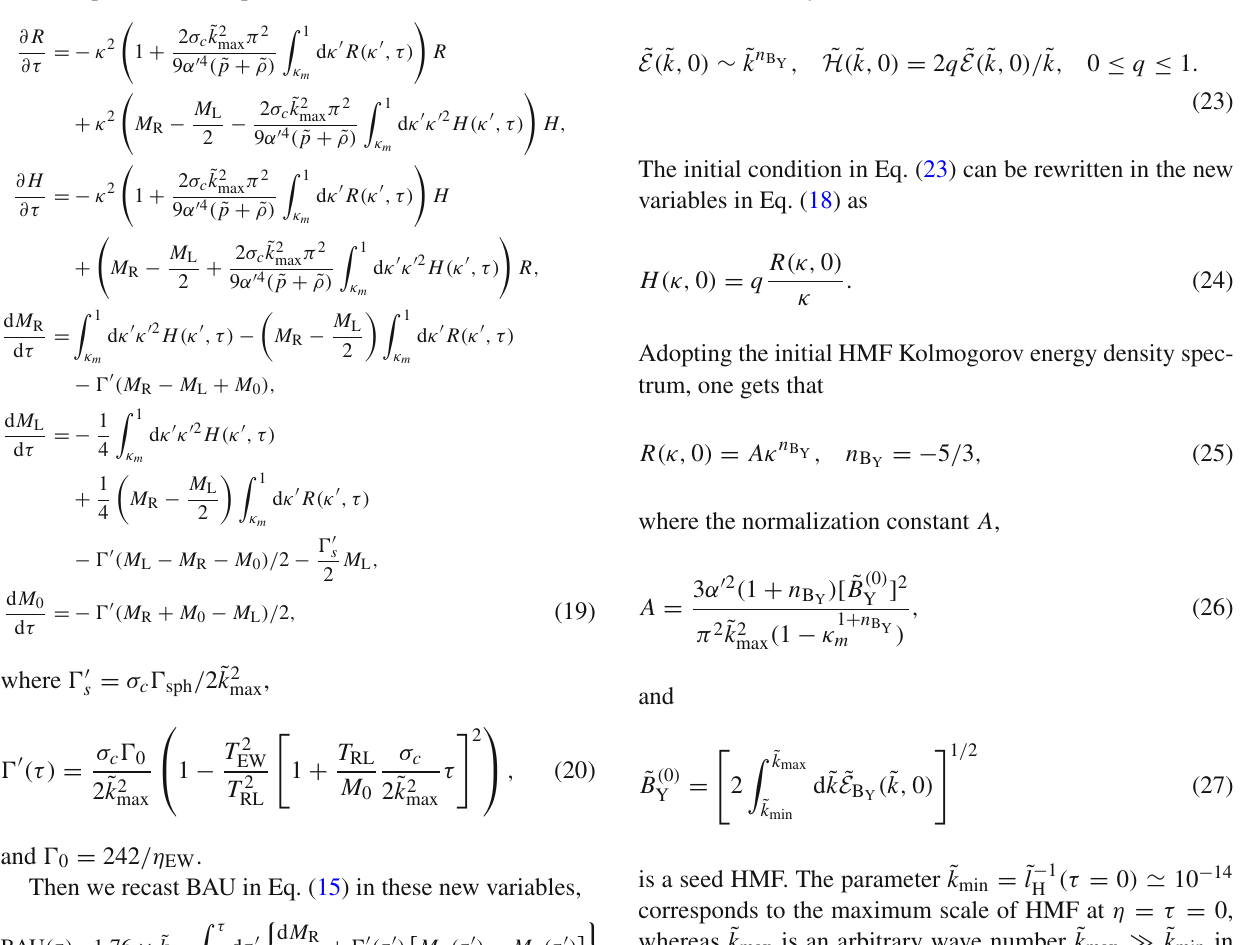
˜ k max is an arbitrary wave number whereas our causal